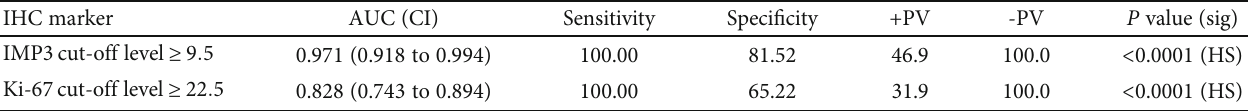
Table 3: ROC curve using IMP3 and Ki-67 to di ff erentiate SCC cases from noncancerous cases. IHC marker AUC (CI) Sensitivity Speci fi